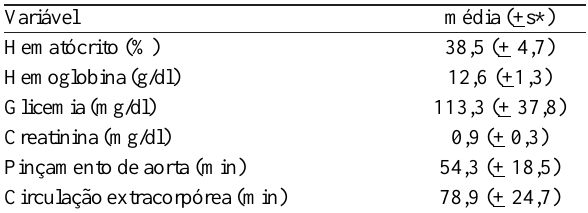
Tabela 2. Exames laboratoriais pré-operatórios e variáveis